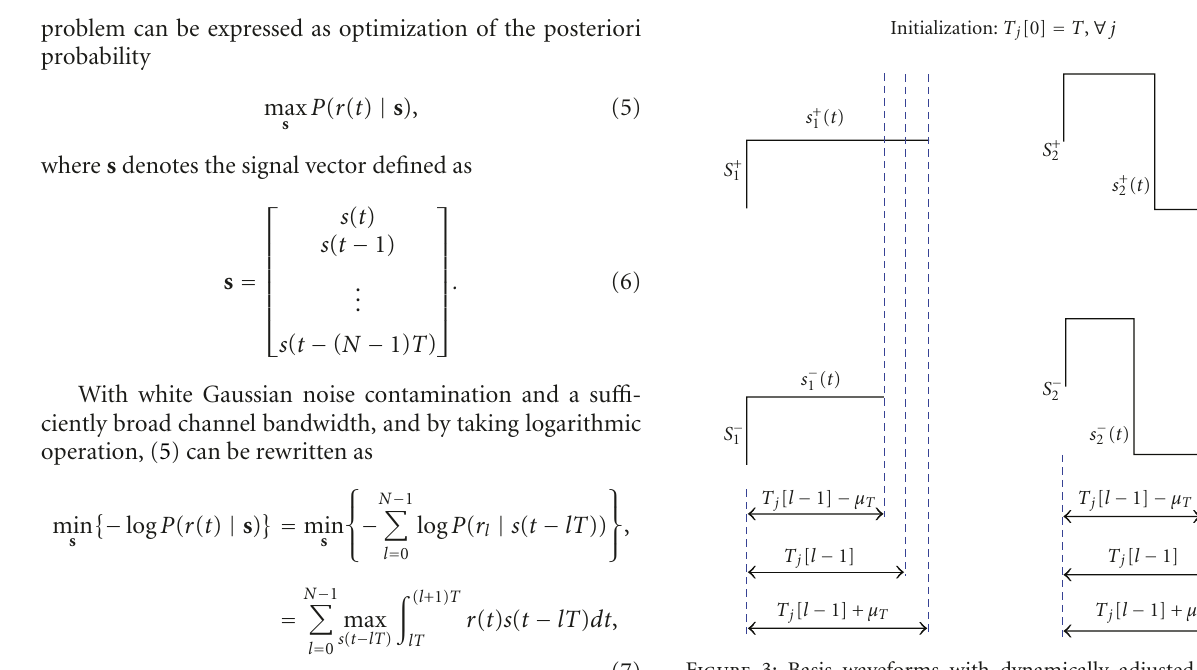
Figure 3: Basis waveforms with dynamically adjusted temporal supports for generating the substates of the JVSS